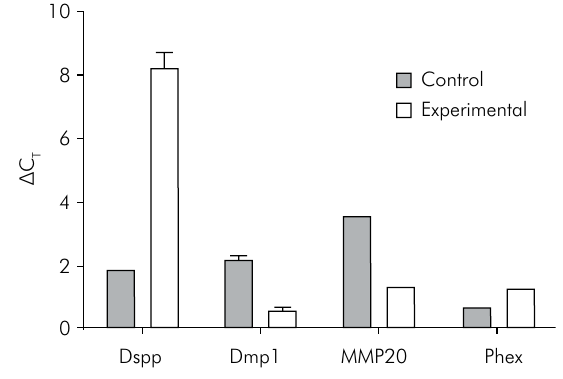
Figure 6. The expression levels of Dspp, Dmp1, MMP20 and Phex in the (-) and (+) groups six weeks after